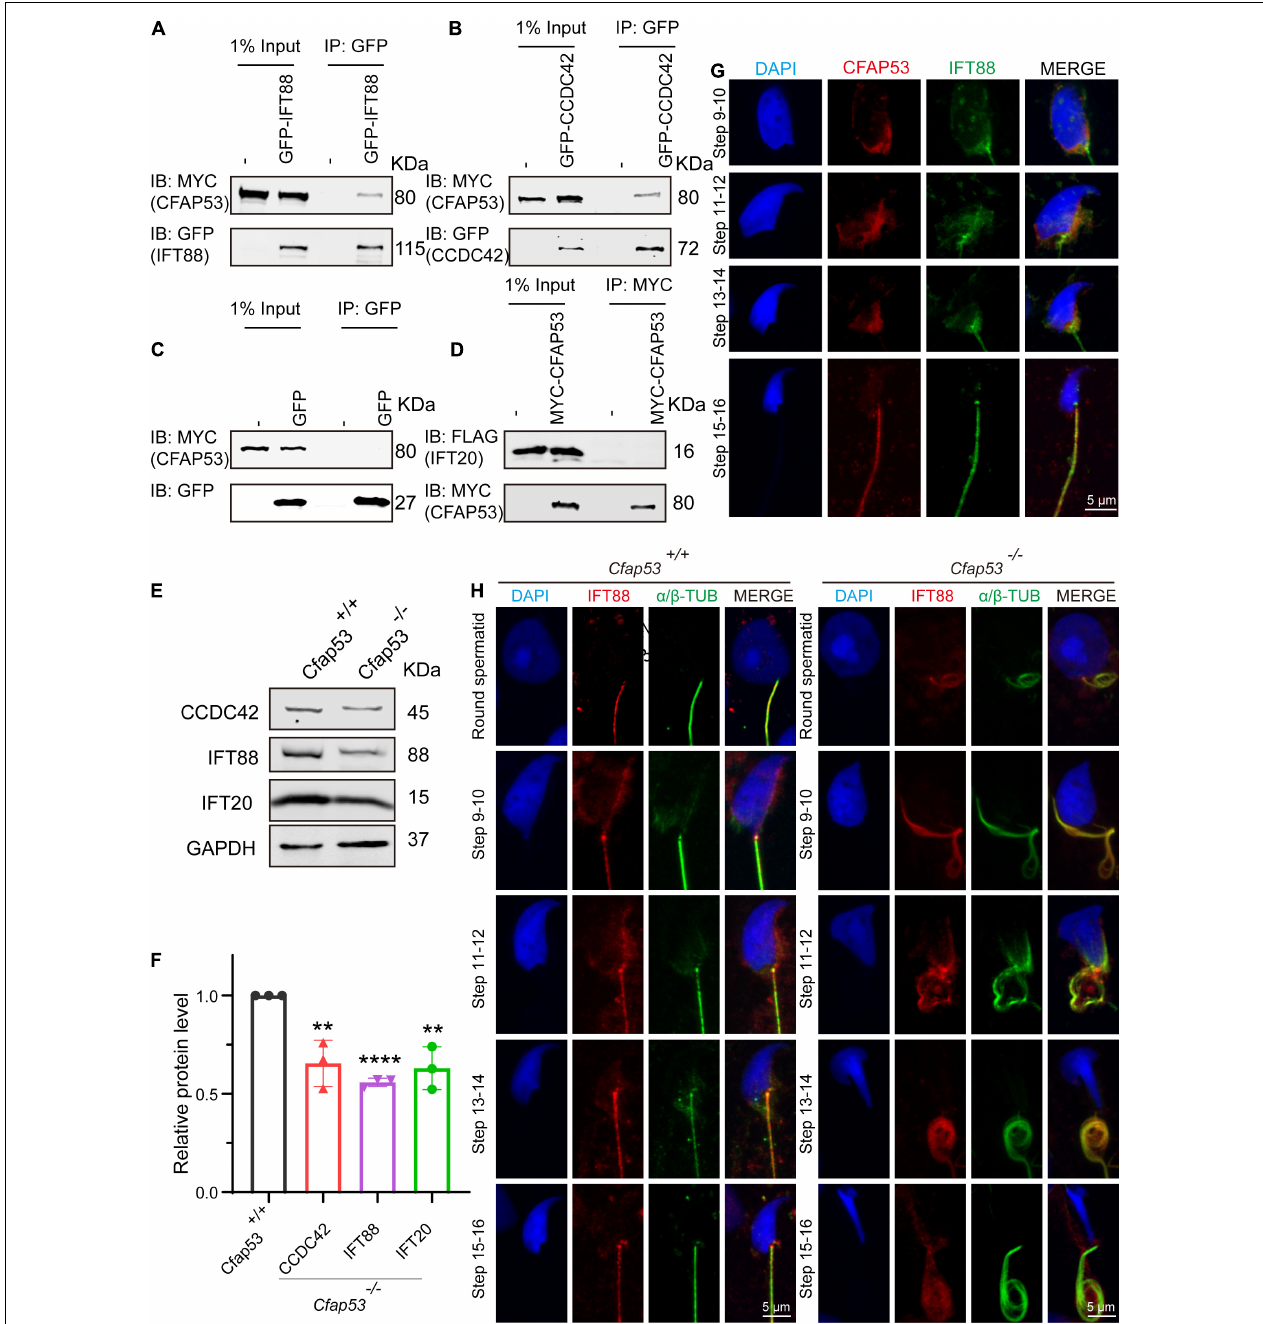
FIGURE 6 | CFAP53 interacts with IFT88 and CCDC42. (A,B) CFAP53 interacts with IFT88 and CCDC42. pCS2-Myc-Cfap53 and pEGFP-GFP-Ift88 or pEGFP-GFP-Ccdc42 were co-transfected into HEK293T cells. At 48 h after transfection, the cells were collected for immunoprecipitation (IP) with anti-GFP antibody and analyzed with anti-MYC and anti-GFP antibodies. (C) pCS2-Myc-Cfap53 and Empty vector were co-transfected into HEK293T cells. At 48 h after transfection, the cells were collected for IP with anti-GFP antibody and analyzed with anti-MYC and anti-GFP antibodies. (D) pCS2-Myc-Cfap53 and pRK-Flag-Ift20 were co-transfected into HEK293T cells. At 48 h after transfection, the cells were collected for IP with anti-MYC antibody and analyzed with anti-MYC and anti-FLAG antibodies. (E) Western blot analysis showing CCDC42, IFT88, and IFT20 protein levels in Cfap53 + / + and Cfap53 − / − mouse testis lysates. GAPDH served as the loading control. (F) Quantification of the relative protein levels of CCDC42, IFT88 and IFT20 using the Odyssey software and compared with the control group ( n = 3 independent experiments). Data are presented as the mean ± SD. The statistical significance of the differences between the mean values for the different genotypes was measured by Student’s t -test with a paired, two-tailed distribution. ** P < 0.01 and **** P < 0.0001. (G) The immunofluorescence analysis of IFT88 (green) and CFAP53 (red) was performed in testicular germ cells. The nucleus was stained with DAPI (blue). (H) Immunofluorescence staining with antibodies against IFT88 (red) and α / β -tubulin (green) in spermatids at different developmental stages from Cfap53 + / + and Cfap53 − / − adult mice. The nucleus was stained with DAPI (blue).